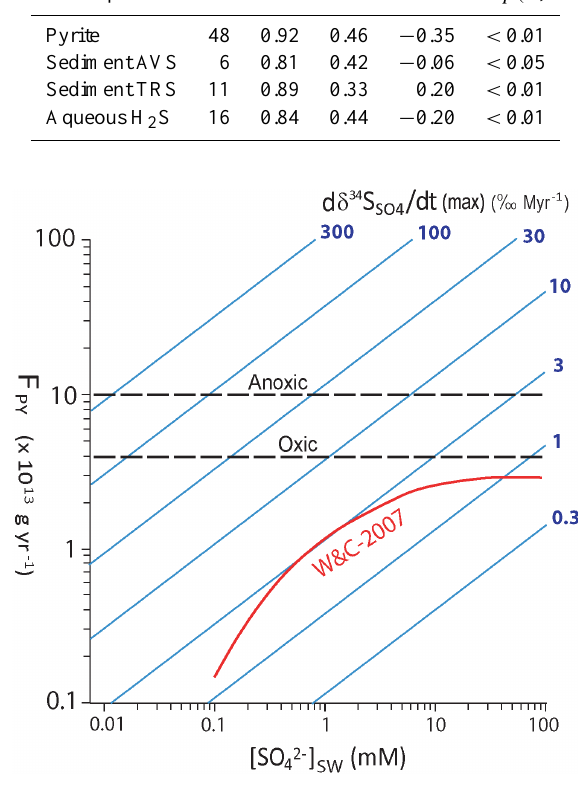
Figure A1. Relationship of ∂δ 34 S CAS /∂t (max) to F PY and [SO 2 − ] SW , with (cid:49) 34 S CAS-PY estimated as a function of 4 [SO 2 − ] SW (Fig. 2, Eq. 6). The dashed horizontal lines represent the 4 pyrite burial fluxes used in this study for oxic and anoxic paleoma- rine systems, i.e., 4 × 10 13 and 10 × 10 13 gyr − 1 , respectively. The red line represents the [SO 2 − ] SW dependency of the pyrite burial 4 flux as given by Wortmann and Chernyavsky (2007, their Fig. 4). Note that, according to the latter relationship, ∂δ 34 S CAS /∂t (max) values cannot exceed ∼ 3‰Myr − 1 under any set of